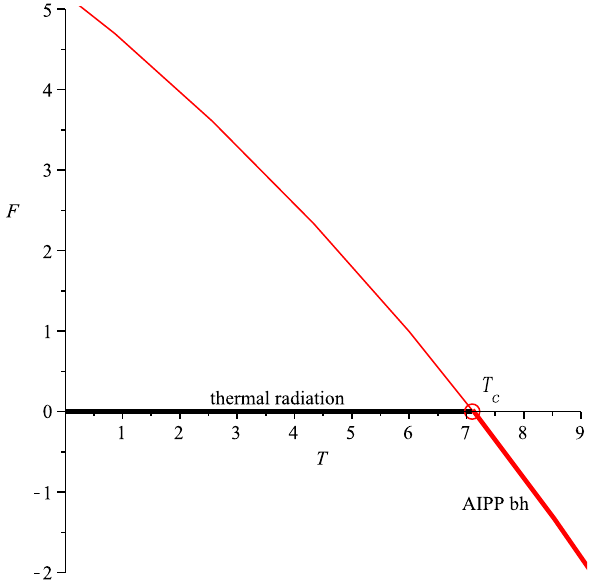
Fig. 1 The free energy F of anyon IPP black hole relates to the tem- perature T when C (cid:8) = 0 , m = 1 located in T c indicates Hawking–Page transition between the anyon IPP black holes and the pure thermal